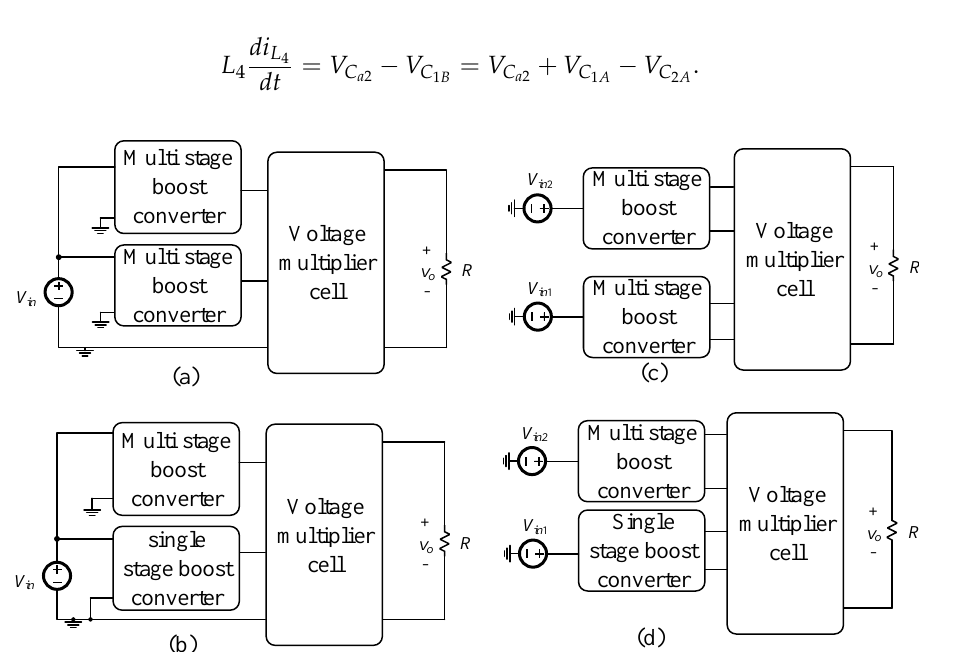
Figure 1. The general structure of the proposed converter ( a ) both phases have a multistage boost converter and fed by a single source ( b ) phases have different numbers of stages and are fed by a single source ( c ) both phases have the same number of cascaded boost stages, but they are fed by two independent sources ( d ) each phase has a different number of stages and two independent voltage sources feed them.